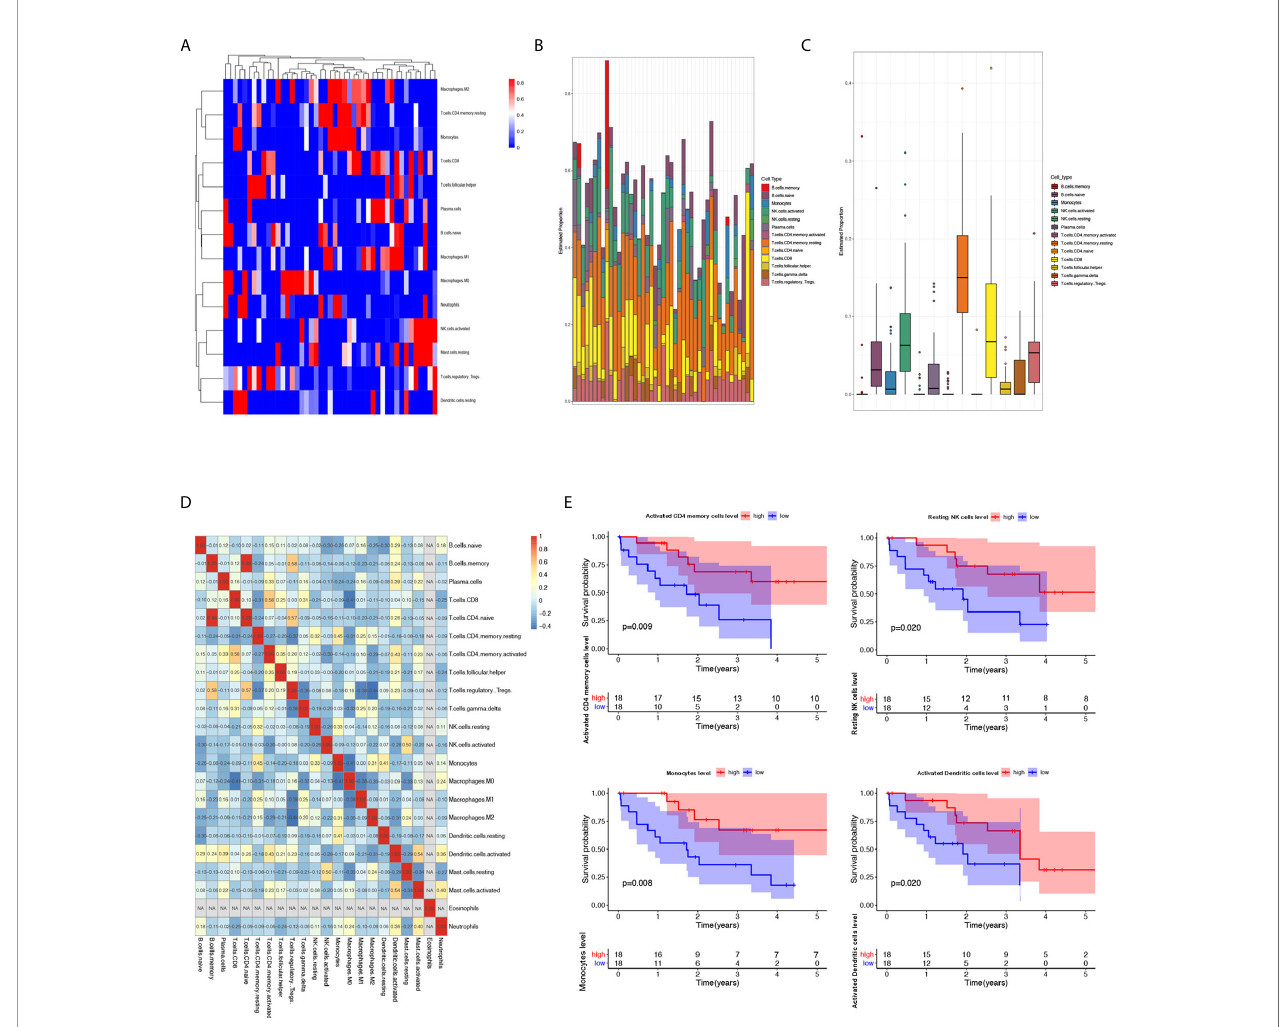
FIGURE 2 | Landscape of immune in fi ltration in cholangiocarcinoma patients in the TCGA data sets. (A – C) Supported evidence indicated that TILs are highly of prognostic and predictive value for various kinds of tumors. According to the CIBERSORT algorithm, the evaluation of the abundance ratio of 22 immune cells in CCA tissues was performed. (D) Associated heat map illustrated that B cell memory and T cell CD4 naive were signi fi cantly correlated, and macrophage M1 was negatively associated with regulatory T cell in CCA. (E) Kaplan-Meier analysis was carried out to further identify the correlation between prognosis value and the 22 types of immune cells abundance ratio. We found out that T cells CD4 memory activated, NK cells resting, monocytes, and dendritic cell abundance ratio were associated to the prognosis of CCA